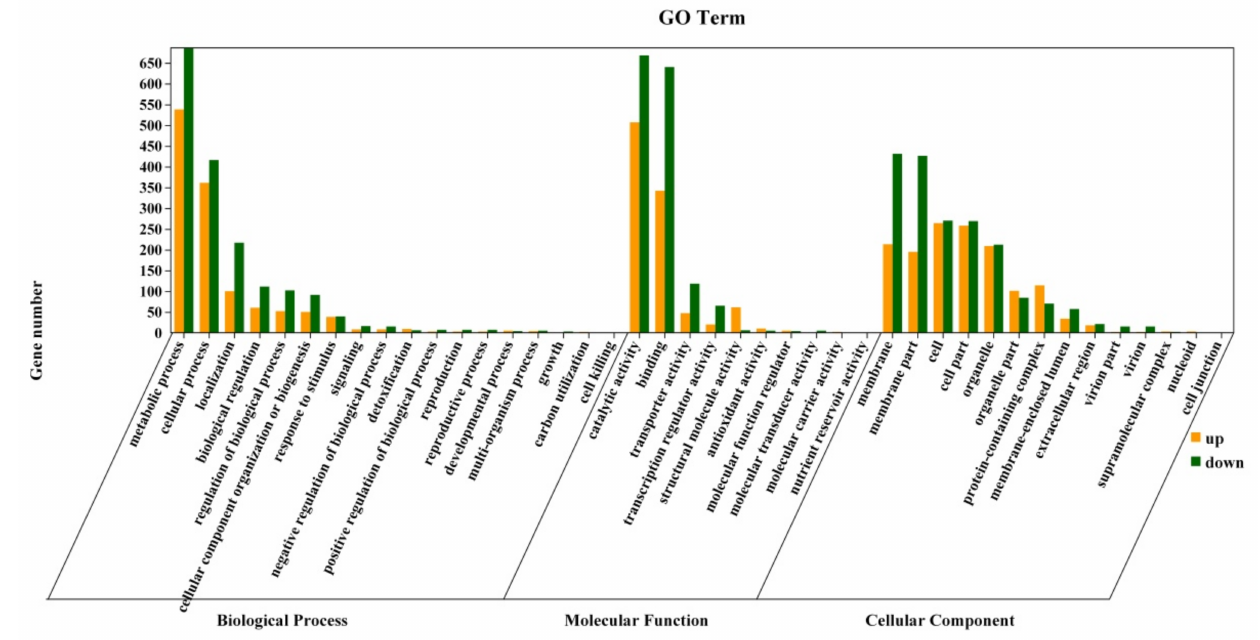
Figure 9. GO Analysis of differential genes of A. flavus